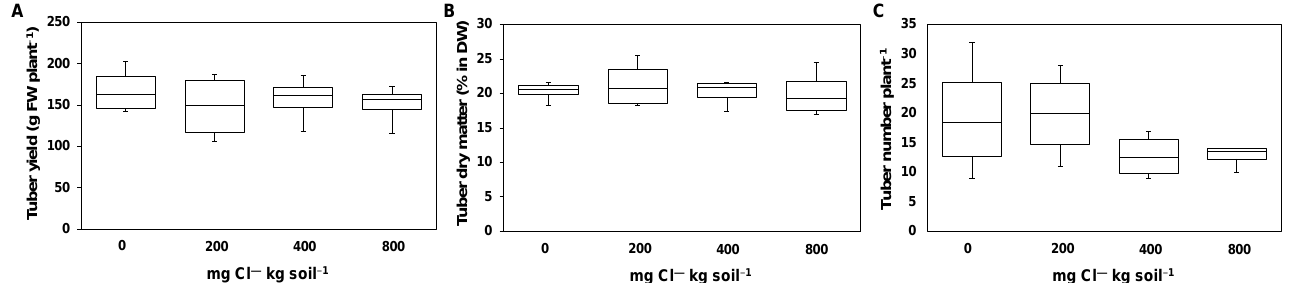
Figure 3. The effect of increasing chloride (Cl ― )-fertilization on plant height and relative leaf chlo- rophyll concentrations. Plant height at seven different times during the growth period from day 21 to day 64 after planting ( A ) and relative chlorophyll concentrations indicated by the dimensionless SPAD value in young ( B ) and old leaves ( C ) at four different times during plant growth from 35 until 56 days after planting. Plants were treated with four Cl ― supplies: 0 mg Cl ― kg soil −1 (control plants); 200 mg Cl ― kg soil −1 ; 400 mg Cl ― kg soil −1 ; 800 mg Cl ― kg soil −1 . Mean ± SE values; n = 4. Different lowercase letters indicate significant differences between Cl ― treatments at one time point and one plant age (young or old leaves) determined by multiple contrast test. Levels of sig- nificance: p < 0.05.